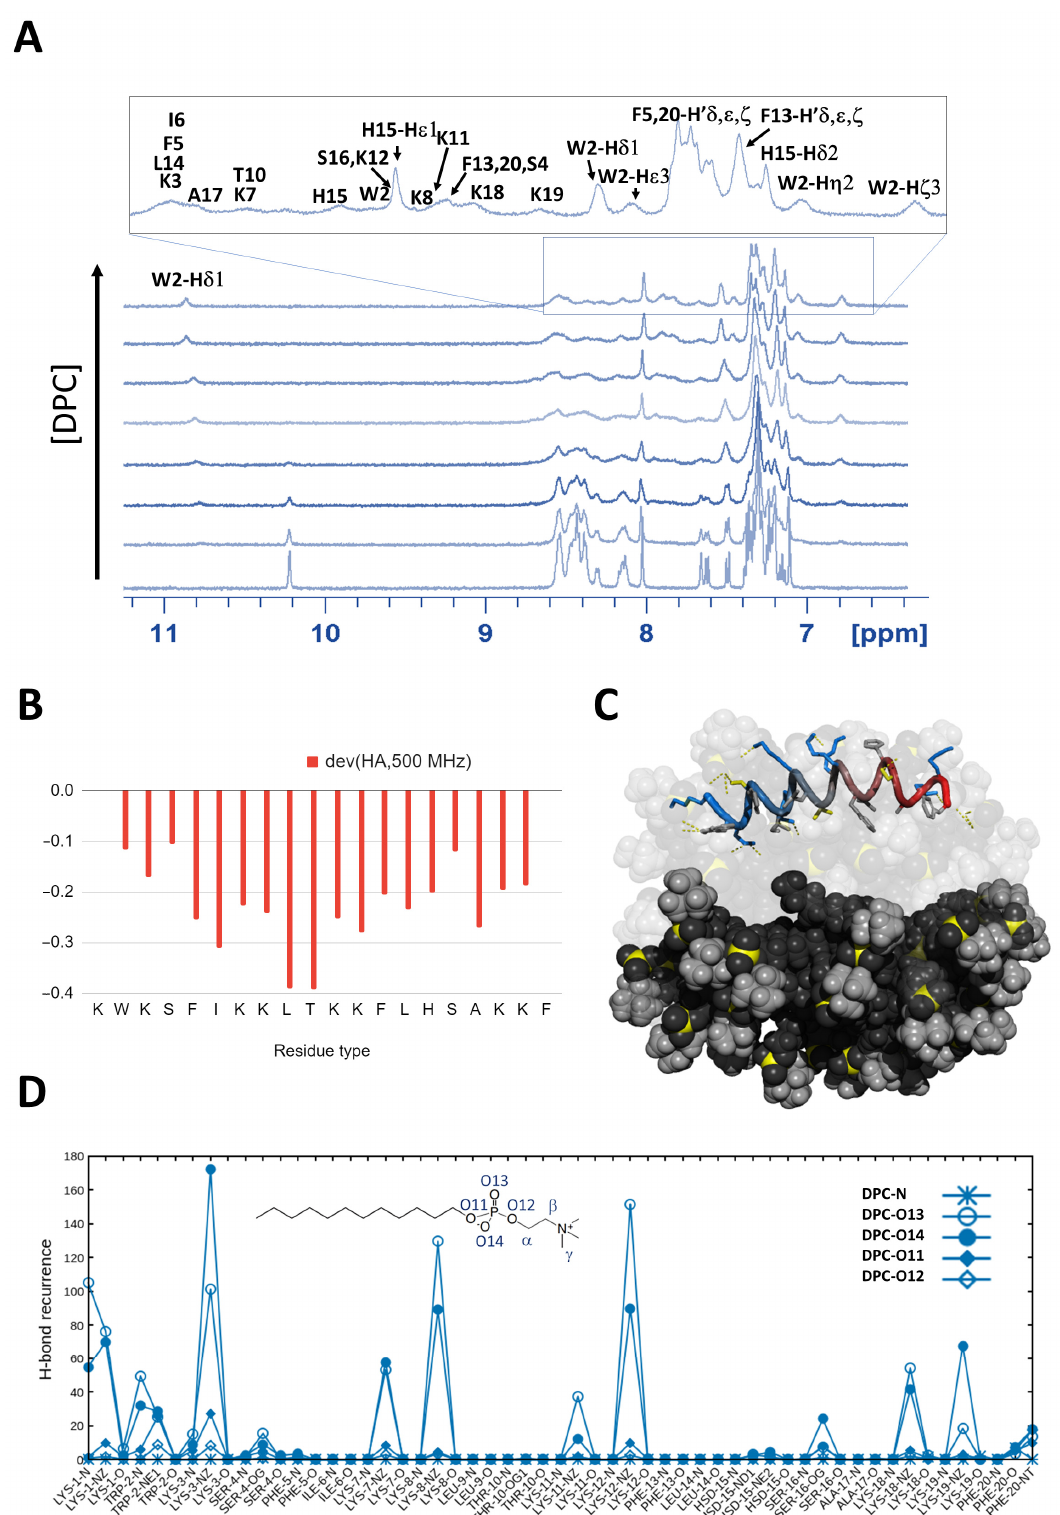
Figure 2. ( A ) 1 H NMR spectra of K11 1 mM in the presence of DPC at concentrations 1, 2, 4, 10, 20, 30, 60 mM. The NMR assignment in the presence of micelles is also shown. ( B ) Chemical shift deviations from random coil values of H α protons whose negative deviations indicate an alpha helical conformation; ( C ) MD snapshot of K11 interacting with DPC micelles; ( D ) Polar contacts recurrence (H-bonds and salt bridges) along MD simulation.